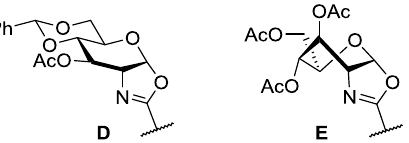
Figure 2. Carbohydrate conformations of sugar-annulated 1,2-oxazoline ligands in the presence ( D ) and absence ( E ) of cyclic protecting groups.